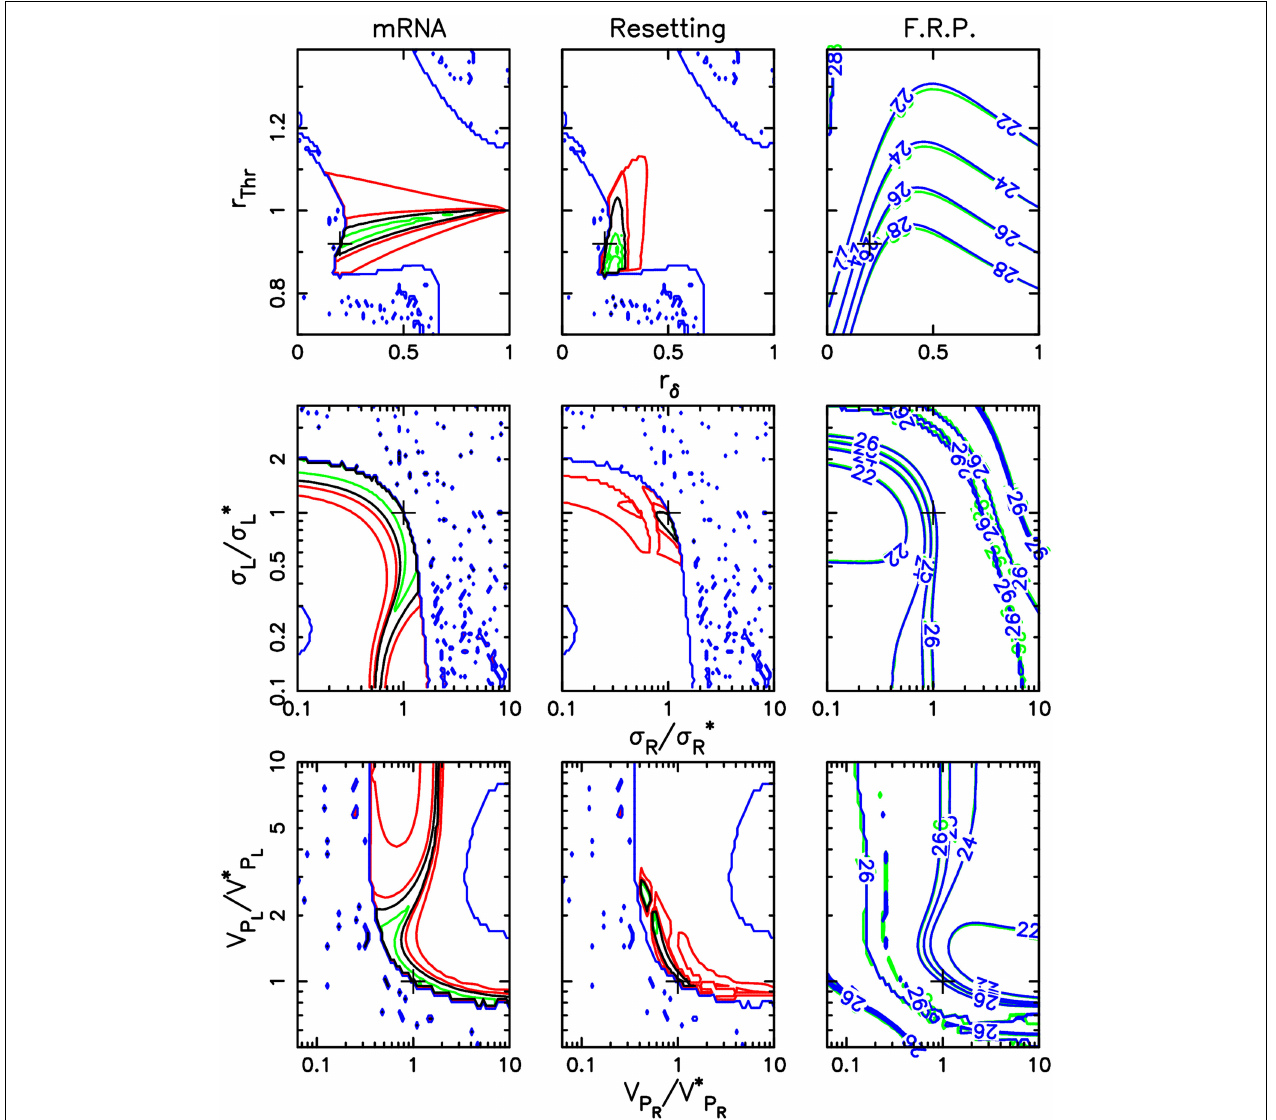
FIGURE 3 | Sensitivity of adjustment to key control parameters. This figure recapitulates how the three different datasets constrain the parameters of the mathematical model. For each parameter set, the adjustment procedure computes a score which is the sum of the partial scores for each dataset. Global adjustment thus results from a compromise between the three partial adjustments. The parameter values selected in the global adjustment are indicated by a cross. The first two columns display contour lines of the scores specific to mRNA LD 12:12 time profiles (first column) and to resetting experiments (second column). The third column shows contour lines of the FRP value at high intensity in blue or green light (optimal scores are obtained with FRPs close to 26h). In each column, the contour lines are displayed in two-parameter planes characterizing how the TCS acts on TOC1 (TOC1 degradation rate and transcriptional activity modulation depths r δ and